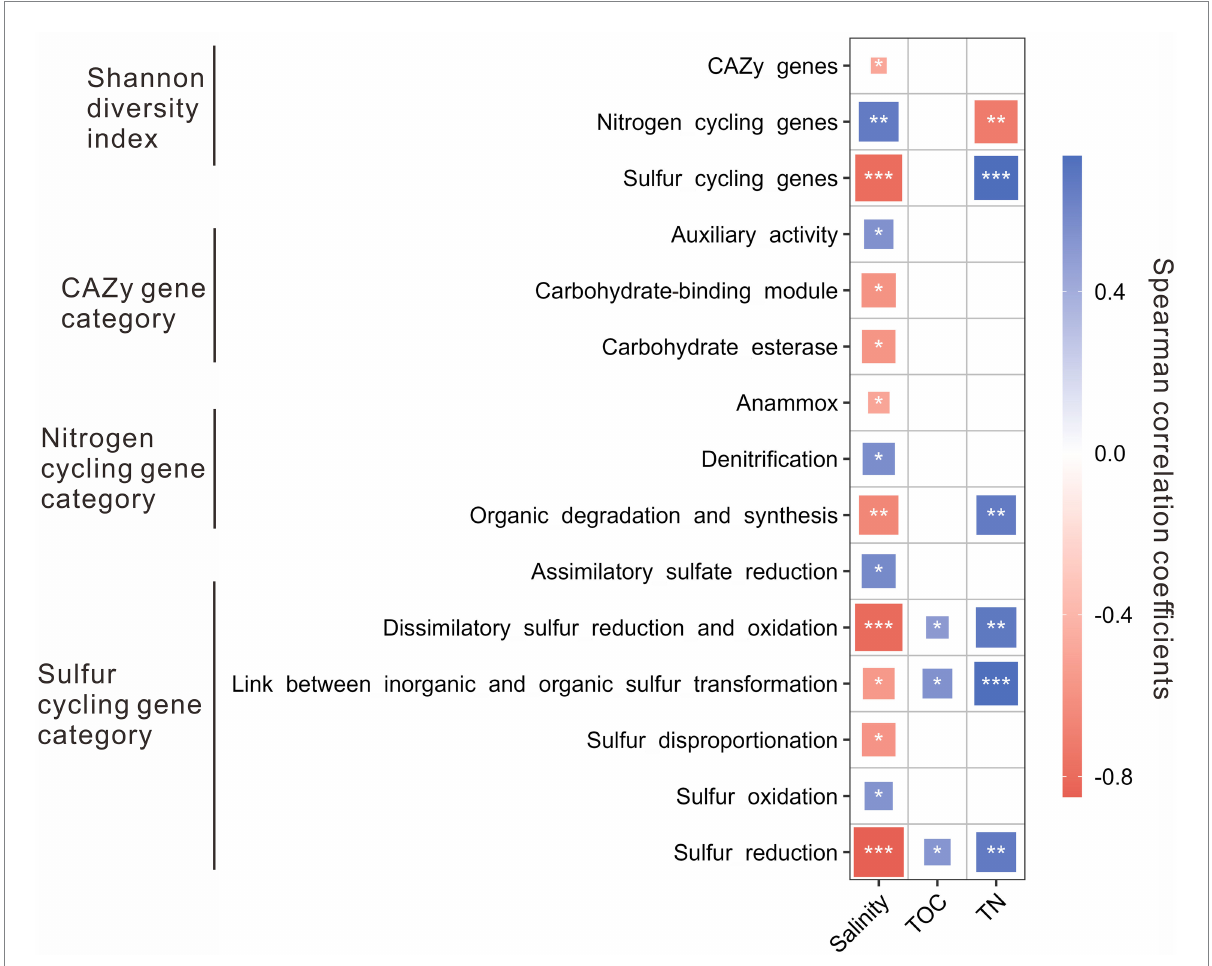
FIGURE 3 Spearman correlations between environmental factors (e.g., salinity, TOC, and TN) and the Shannon diversity of genes/relative abundances of gene categories related to the CAZy, nitrogen, and sulfur cycling in the studied lake sediments. Only significant ( p < 0.05) correlations are shown in the figure. * p < 0.05, ** p < 0.01, *** p <